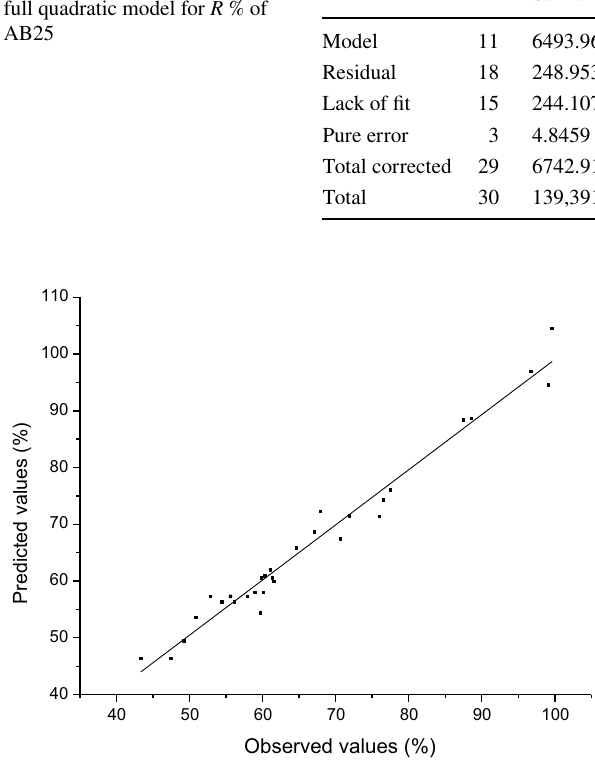
Fig. 4 The predicted data versus the experimental data of normalized removal of AB25 dye